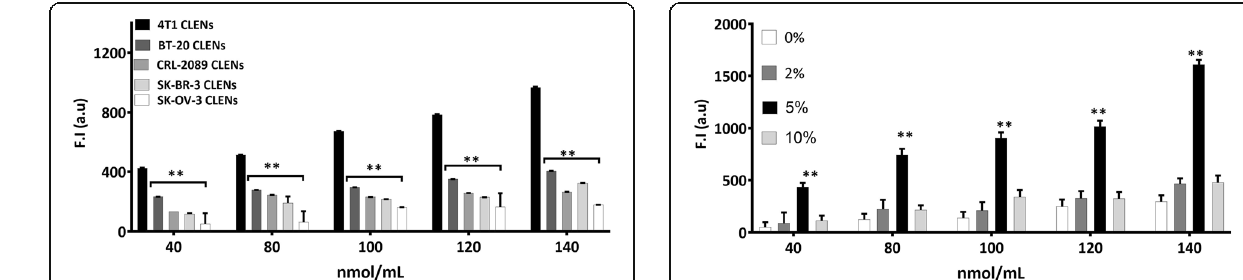
Fig. 4 Effect of cholesterol and PEG inclusion on cellular uptake of CLENs. Four different preparations of 4 T1 CLENs containing 25 mol% of cholesterol and different mol% of DPPE-PEG- 5000 (0, 2, 5 and 10%) were evaluated for cellular uptake against 4 T1 cell line. Rhodamine-labeled CLENs were used for this study. The cells were seeded in a 48-well plate followed by the addition of CLENs for 24 h. The fluorescence intensity used here as an indicator of cell uptake was measured using a fluorescence microplate reader. CLENs containing 5 mol% of DPPE-PEG- 5000 demonstrated the most significant uptake compared to other varieties within the concentration range employed. Data are presented as mean ± S.D.; ( n = 6)